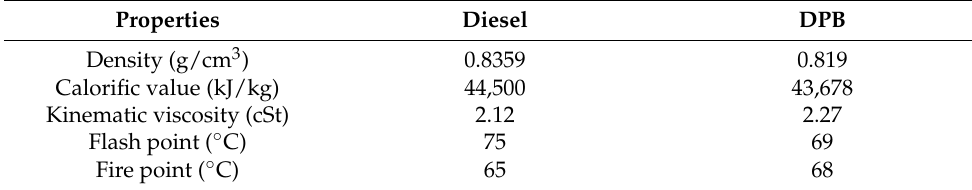
Table 1. Properties of